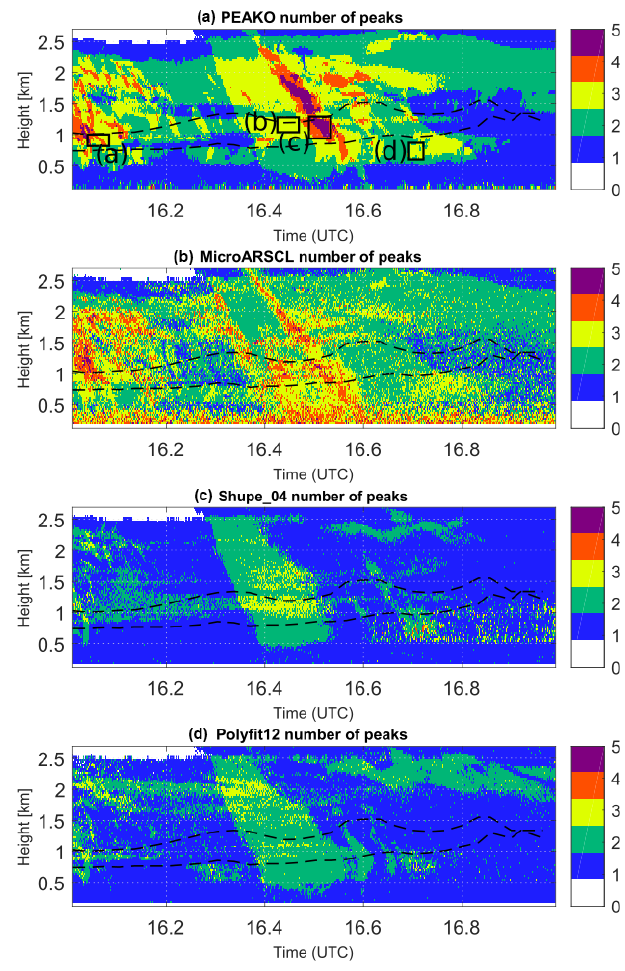
Figure 10. Like Fig. 5 but for 2 February 2014, 16:00 to 17:00UTC, at 0 to 2.7km height. Boxes mark the points in time–height where peaks detected in single spectra are analyzed in greater detail. The dashed lines mark the bottom and top of the SLW layer detected by the HSRL (Fig.